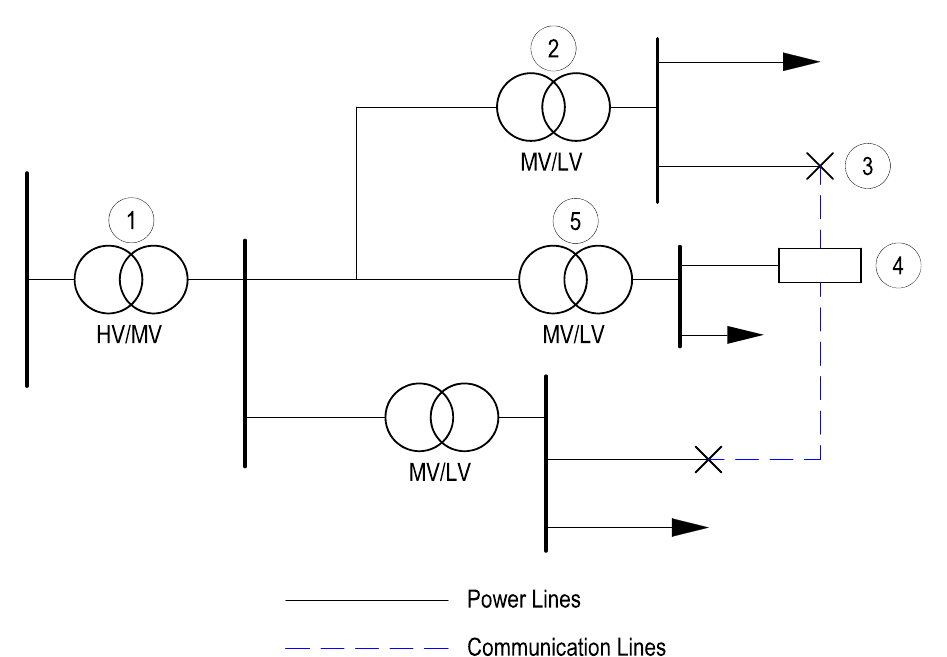
Figure 1. Diagram of the power line supplying the traffic